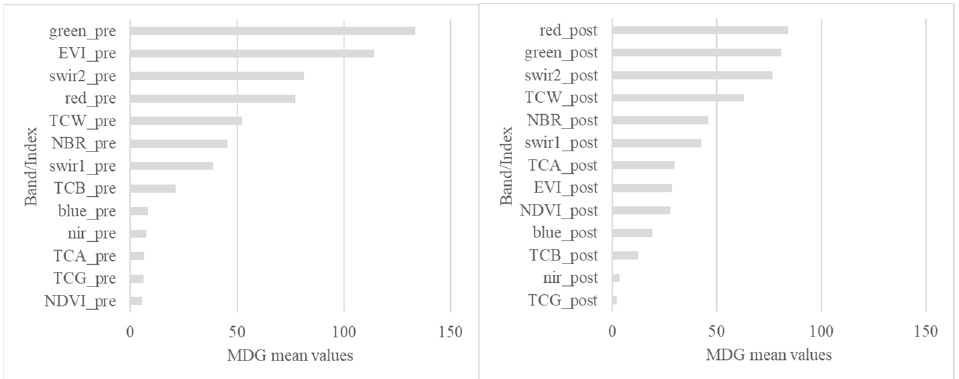
Figure 6. Temporal predictors importance ranking for the indirect approach. In the fi gure, the illus- trated values of the Mean Decrease Gini Index for each band and index for the initial map (1985– 1989, left ) and for the fi nal map (2015–2019, right ).